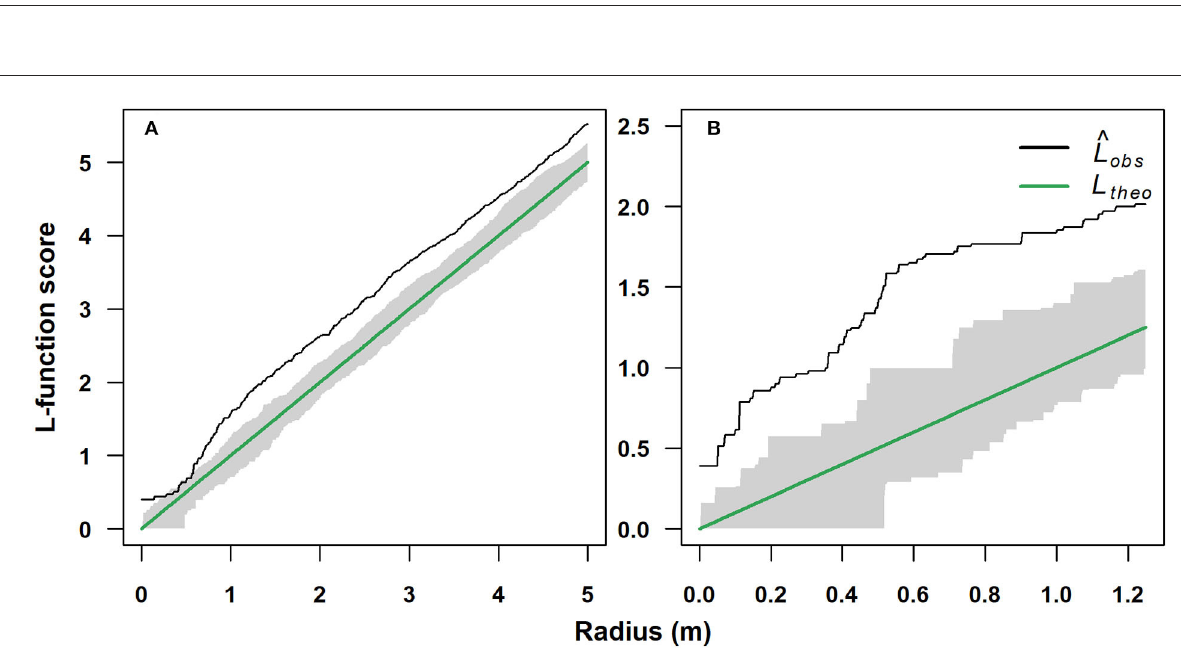
FIGURE4 Standardized univariate L-function spatial pattern analysis of a single-stem and a multi-stem F. sylvatica stands growing at two different elevations on the north-western slope of Serra del Prete: (A) 1,750m (mono-stem) and (B) 2,070m (multi-stem). The solid black line represents the observed empirical L-function (L obs ), while the solid green line represents the theoretical L-function for Poisson random spatial distribution (L theo ). The gray bands represent the 95% acceptance confidence interval (CI) under the hypothesis of complete spatial